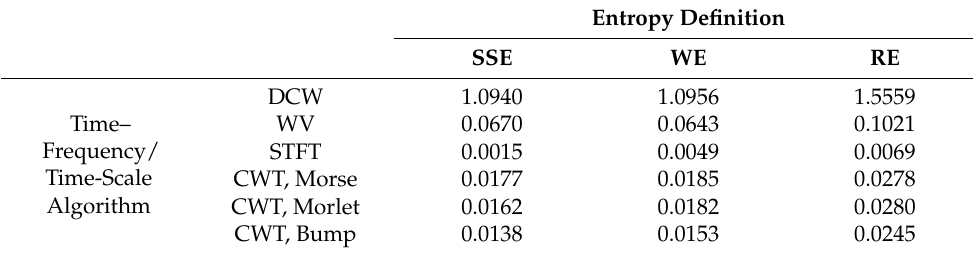
Figure 11. An example of a magnitude scalogram plot for a single frame (6.4 s). The dashed white line marks the cone of influence. Table 2. Total duration (elapsed time t el ,